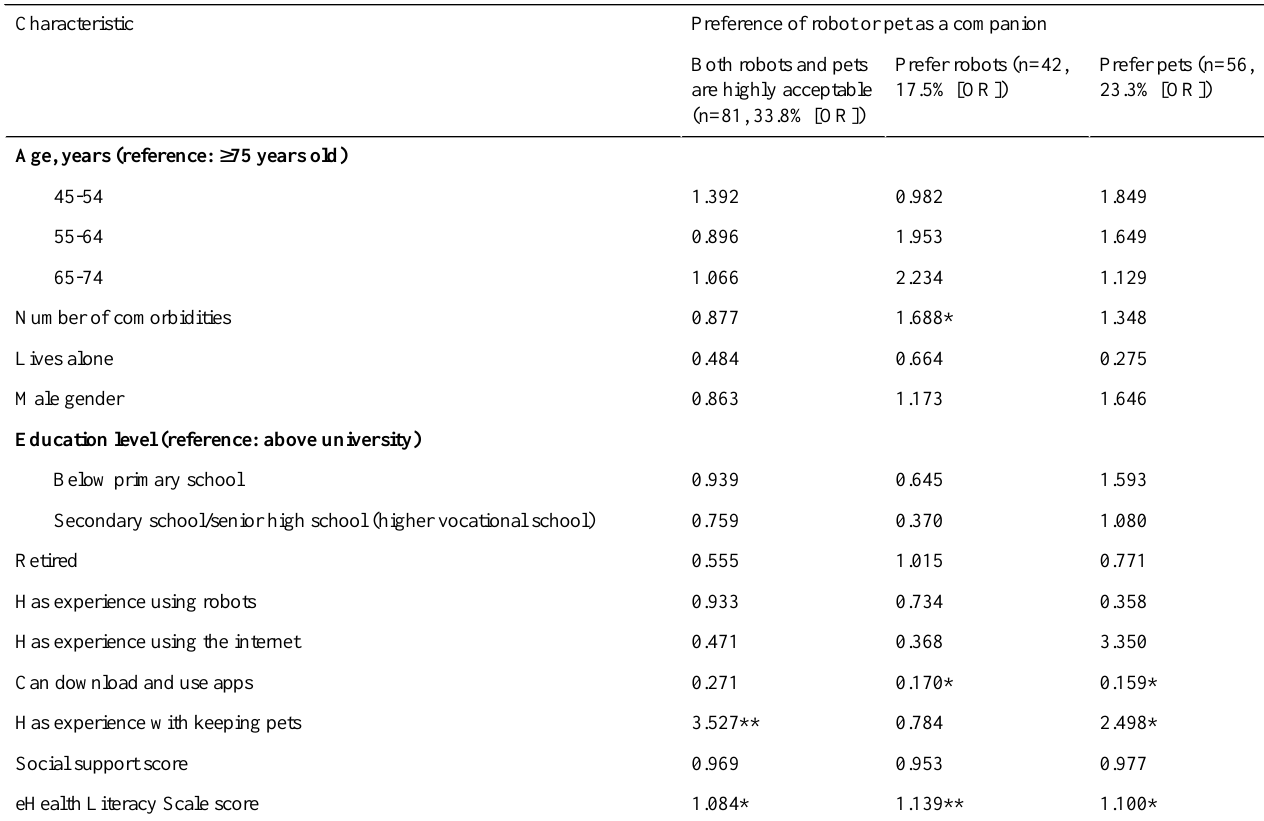
Table 2. Multinomial logistic regression analysis of the degree of acceptance of robots and pets by middle-aged and older adults (N=240). a